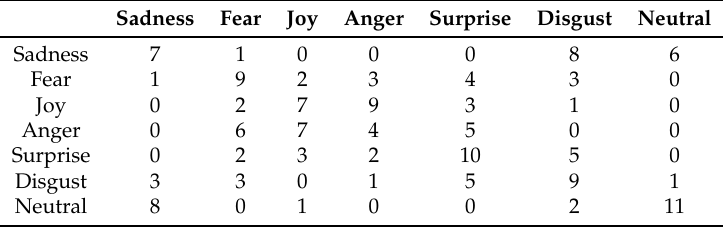
Table A17. P17 actor confusion matrix from the RekEmozio dataset in the second phase.